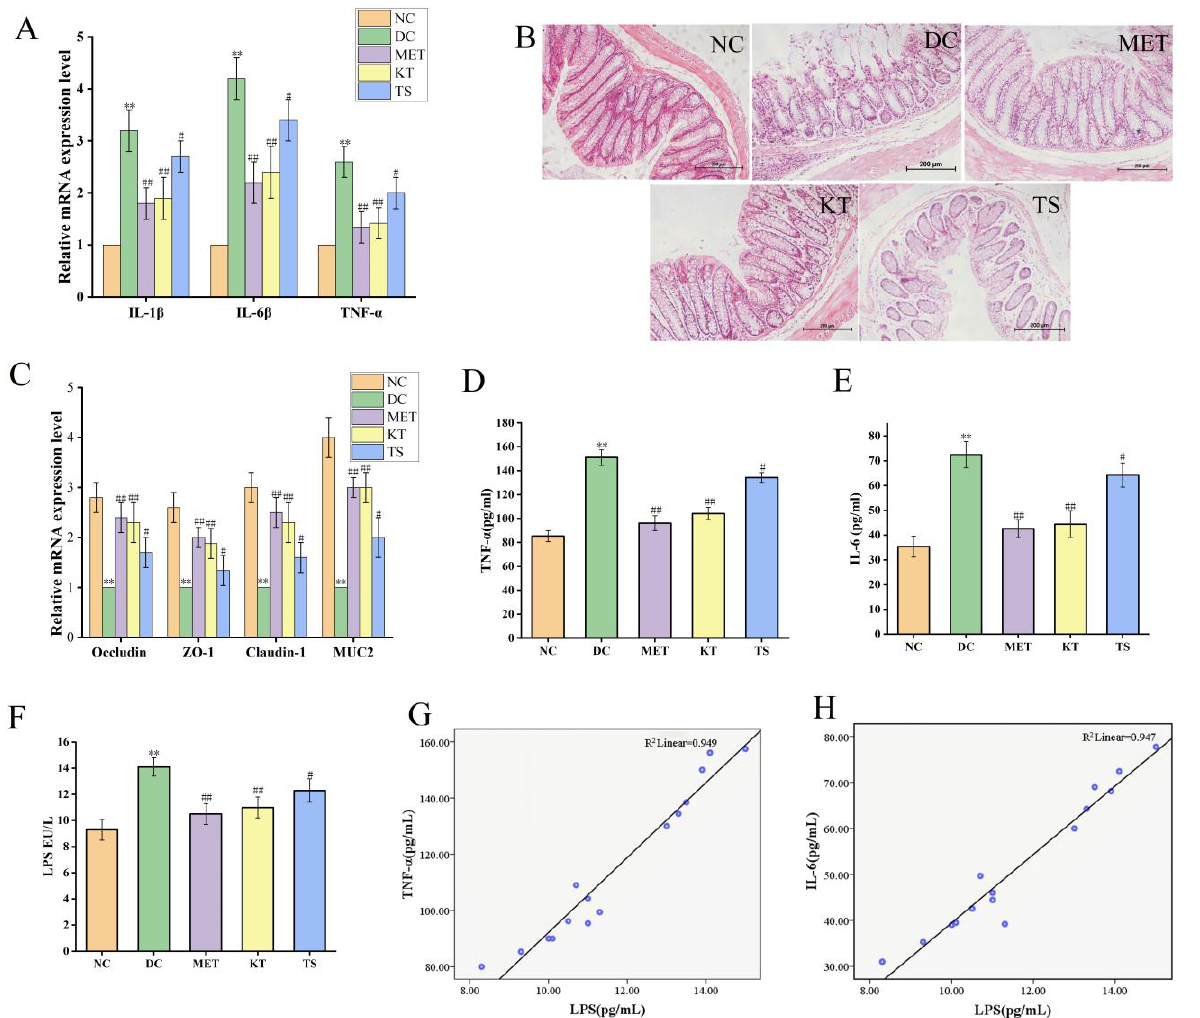
Figure 6. Kombucha improved the intestinal permeability in T2DM mice. ( A ) Relative gene expres- sio n of IL−1β, IL−6 and TNF−α i n the colon; ( B ) Histological examination of colon with H&E staining (scale bars: 200 μm) ; ( C ) The mRNA levels of tight junction protein (TJP) Occludin, ZO − 1, Claudin − 1, (scale bars: 200 µ m); ( C ) The mRNA levels of tight junction protein (TJP) Occludin, ZO-1, and Muc2 in the colon; ( D – F ) The levels of TFN −α , IL − 6 and LPS in the serum. ( G , H ) Correlation analysis of LPS with IL − 6 and TNF −α . ** p < 0.01 vs. Normal; # p < 0.05, ## p < 0.01 vs. Model.